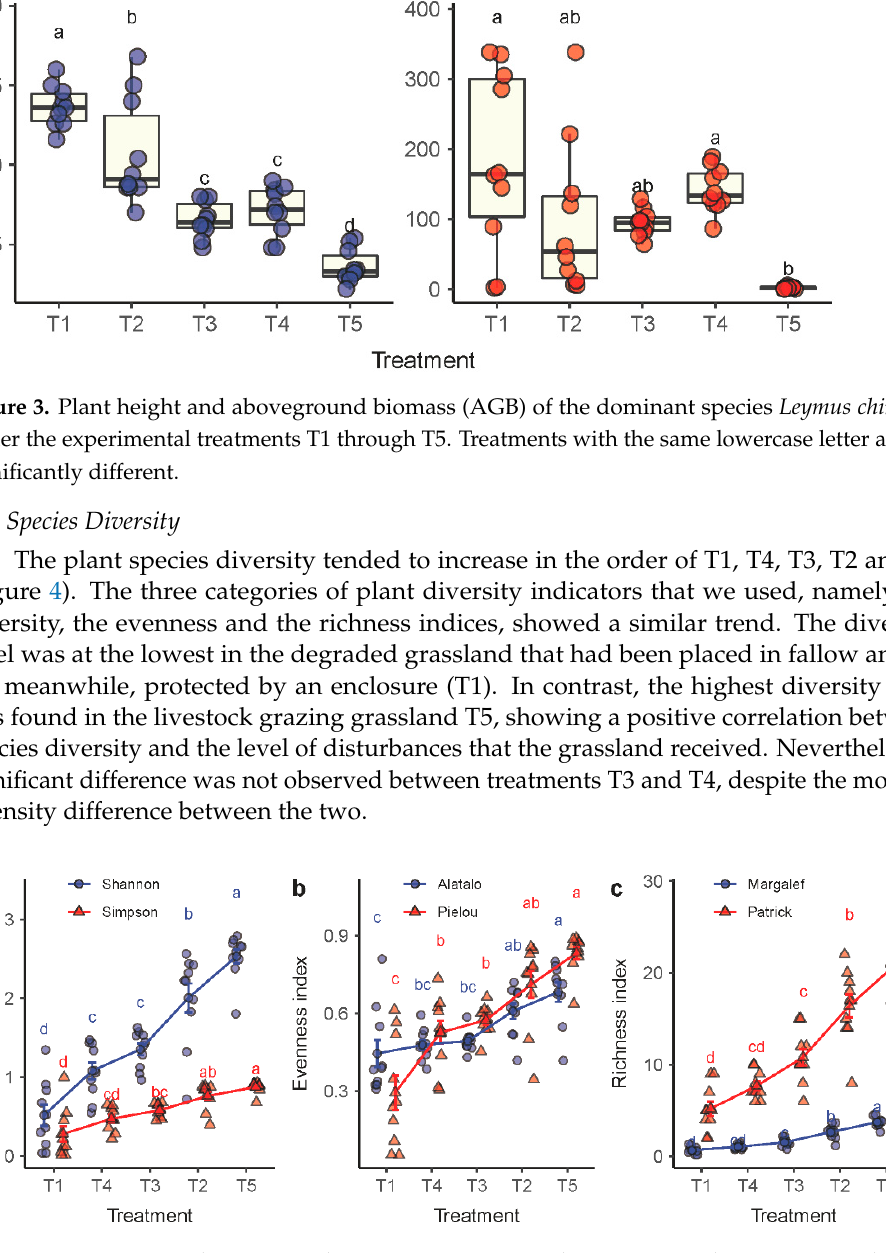
Figure 4. Variations in plant species diversity in response to the experimental treatments T1 through T5. Plant species diversity was measured in three groups of indices: ( a ) the Shannon–Wiener and Simpson’s diversity indices; ( b ) Alatalo’s and Pielou’s evenness indices; and ( c ) the Margalef and the Patrick richness indices. Treatments with the same lowercase letter are not significantly different.